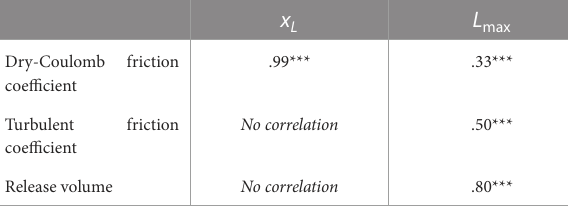
TABLE3 Correlationofinputvariableswithlocation ( x L ) andthelength ( L max )